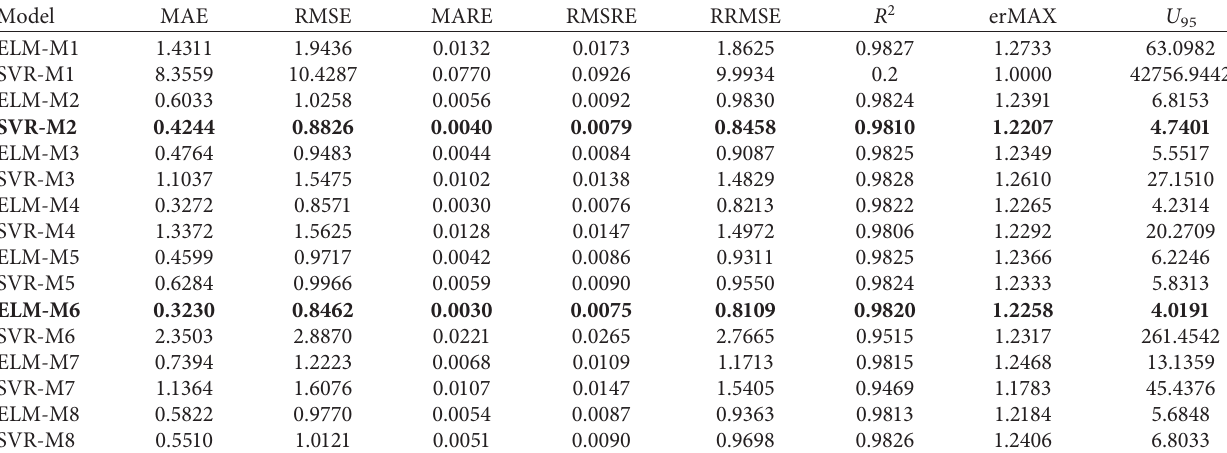
Table 3: Statistical criteria of each predicted models for USGS 14181500 station during the training set.